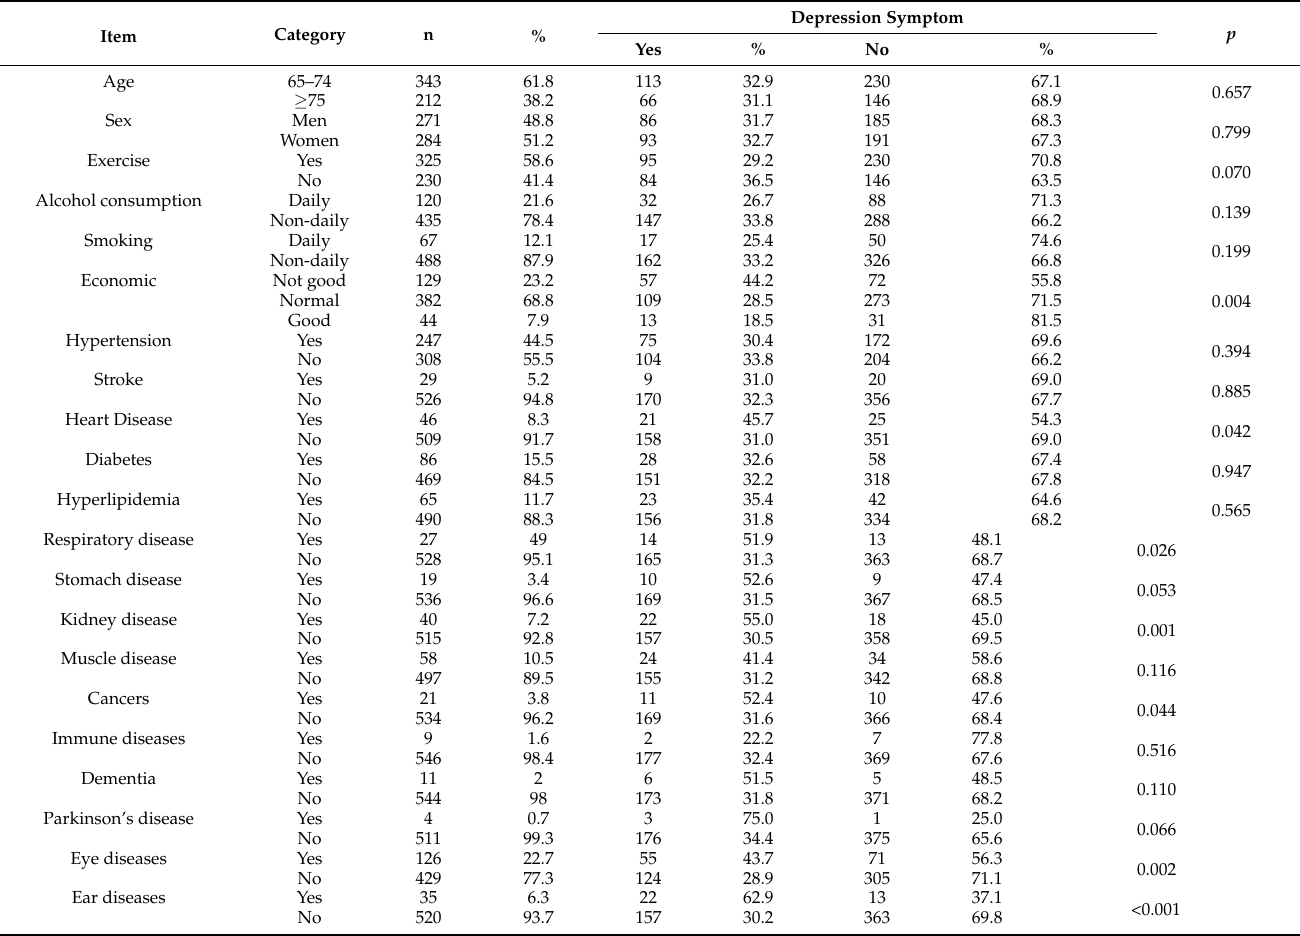
Table 1. Sociodemographic characteristics and distribution of depressive symptoms (N = 555).